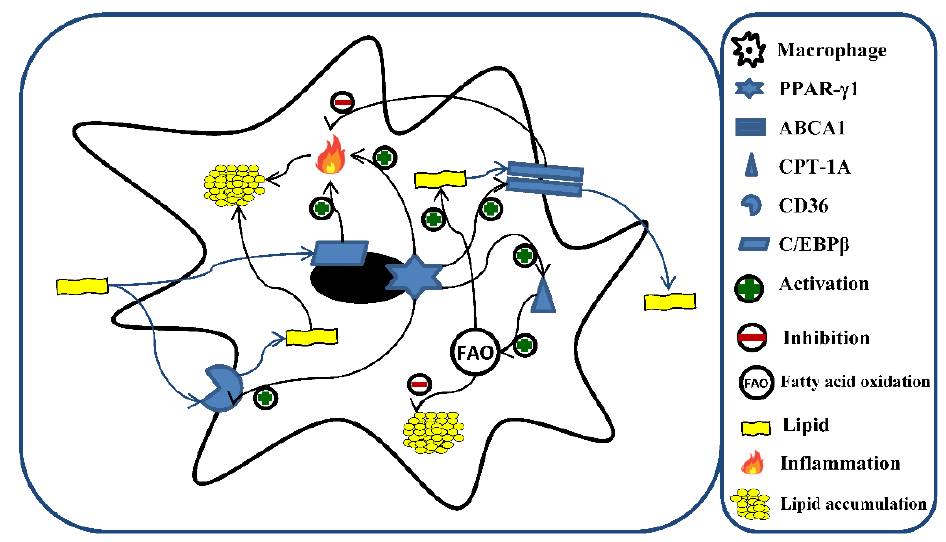
Figure 1. Role of C/EBP β , PPAR- γ 1, CD36, CPT-1A, and ABCA1 in lipid metabolism and fatty acid oxidation (FAO) in macrophages. The excess of lipids is responsible for the induction of different genes involved in the metabolism of fatty acids and the inflammatory process. A central role is represented by PPAR- γ 1, which orchestrates the storage and mobilization of lipids through the activation of CD36, CPT-1A, and ABCA1. Additionally, lipids lead to the activation of CD36 and C/EBP β , which promote intracellular lipid accumulation through the enhancement of lipid uptake and inflammatory response, respectively. Moreover, the activation of CPT-1A, and ABCA1 by the excess of lipids counteract the accumulation of the latter through the stimulation of lipid efflux and increment of fatty acid oxidation, respectively. C/EBP β (CCAAT enhancer-binding protein beta); PPAR- γ (peroxisome proliferator-activated receptor gamma); CD36 (cluster of differentiation 36); CPT-1A (carnitine palmitoyltransferase 1A); ABCA1 (ATP-binding cassette transporter 1).